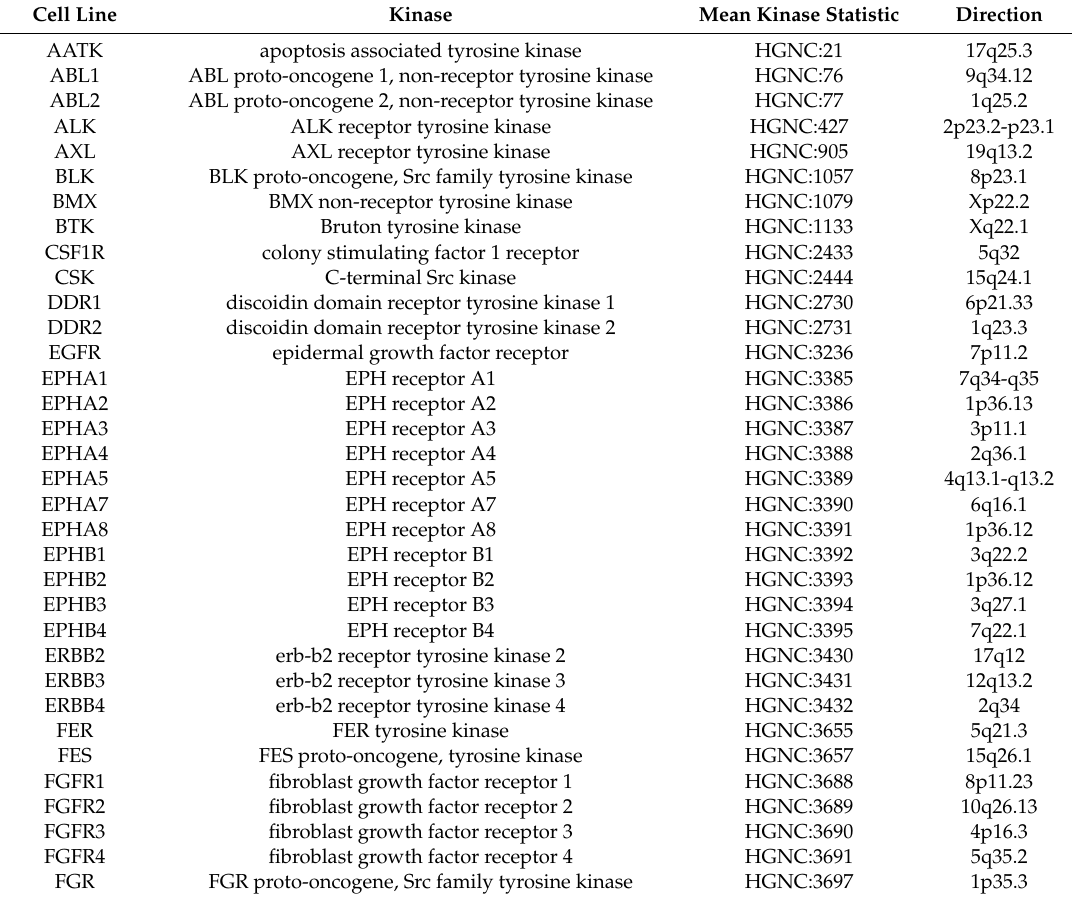
Table A3. Approved human gene